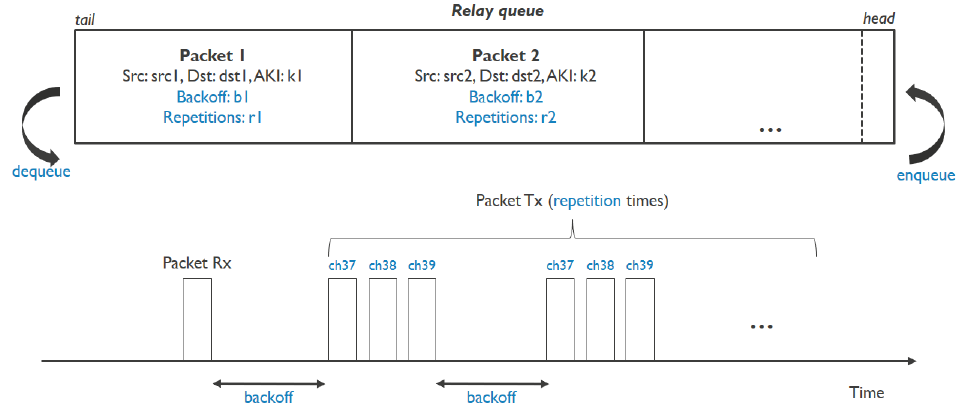
Figure 5. Relay and queue operations in BLE